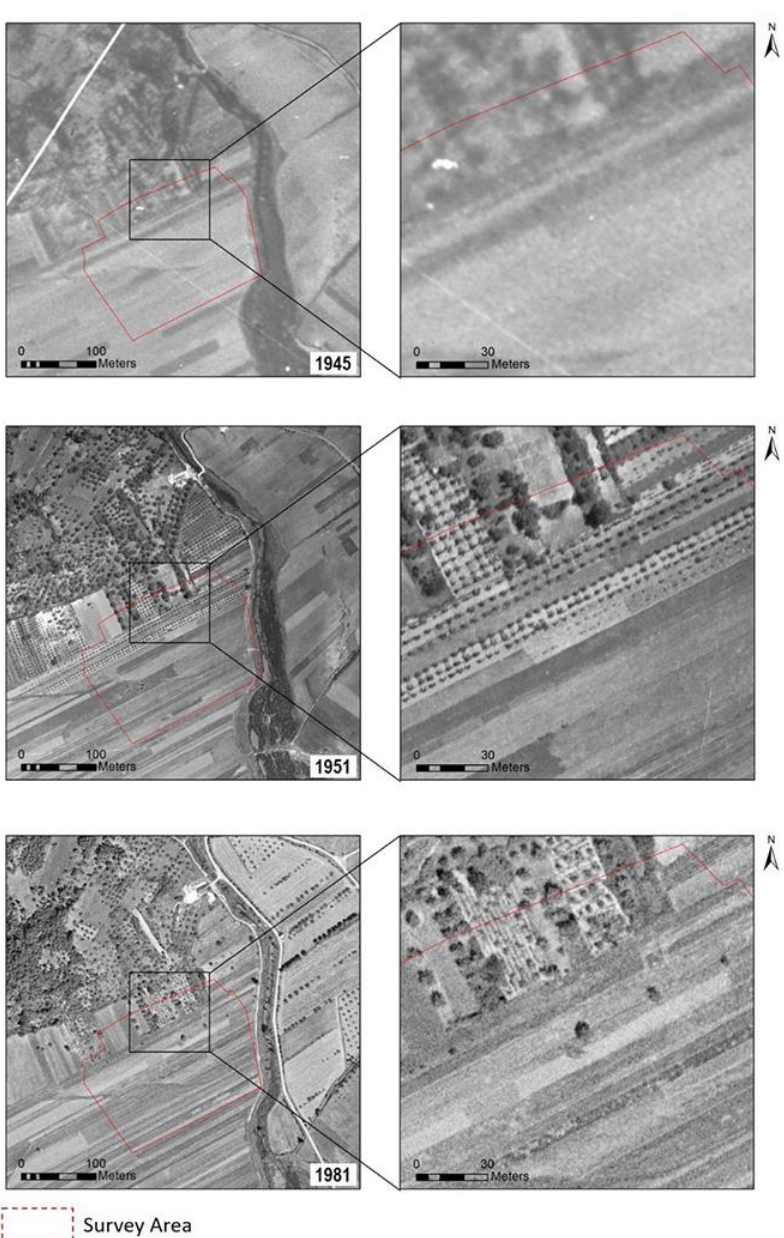
Figure 3. Aerial images acquired by Military Geographical Institute of the Italian State (IGM) during 1945, 1951, and 1981 (Fotografie Aeree dell’Istituto Geografico Militare (Autorizzazione n. 7084 datata 29/06/2021; www.igmi.org).